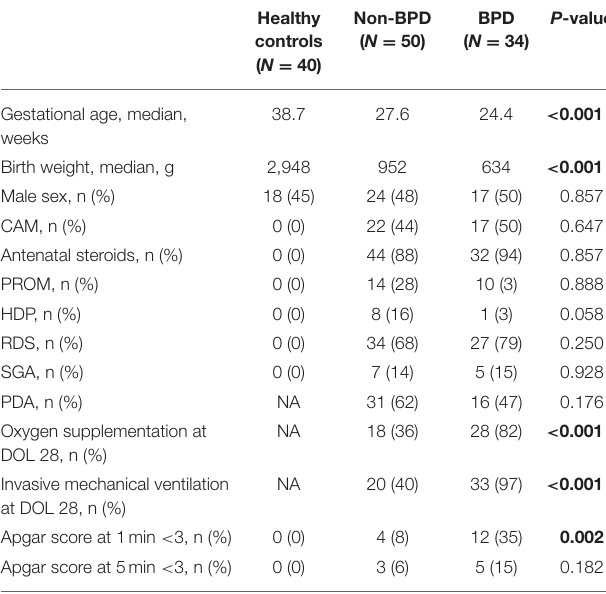
TABLE 1 | Characteristics of